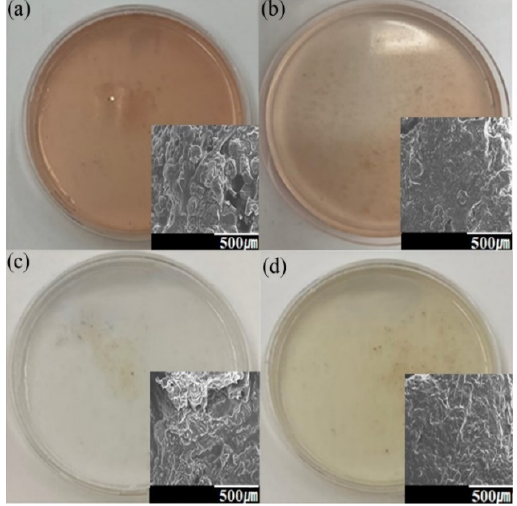
Figure 4. Images of blood diffused in water using SEM for ( a ): unprocessed beef; ( b ): unprocessed halal beef; ( c ): SCF under pressure at 3.04 × 10 7 Pa processed with water as a co-solvent; and ( d ): SCF under pressure at 3.04 × 10 7 Pa processed with oil as a co-solvent.